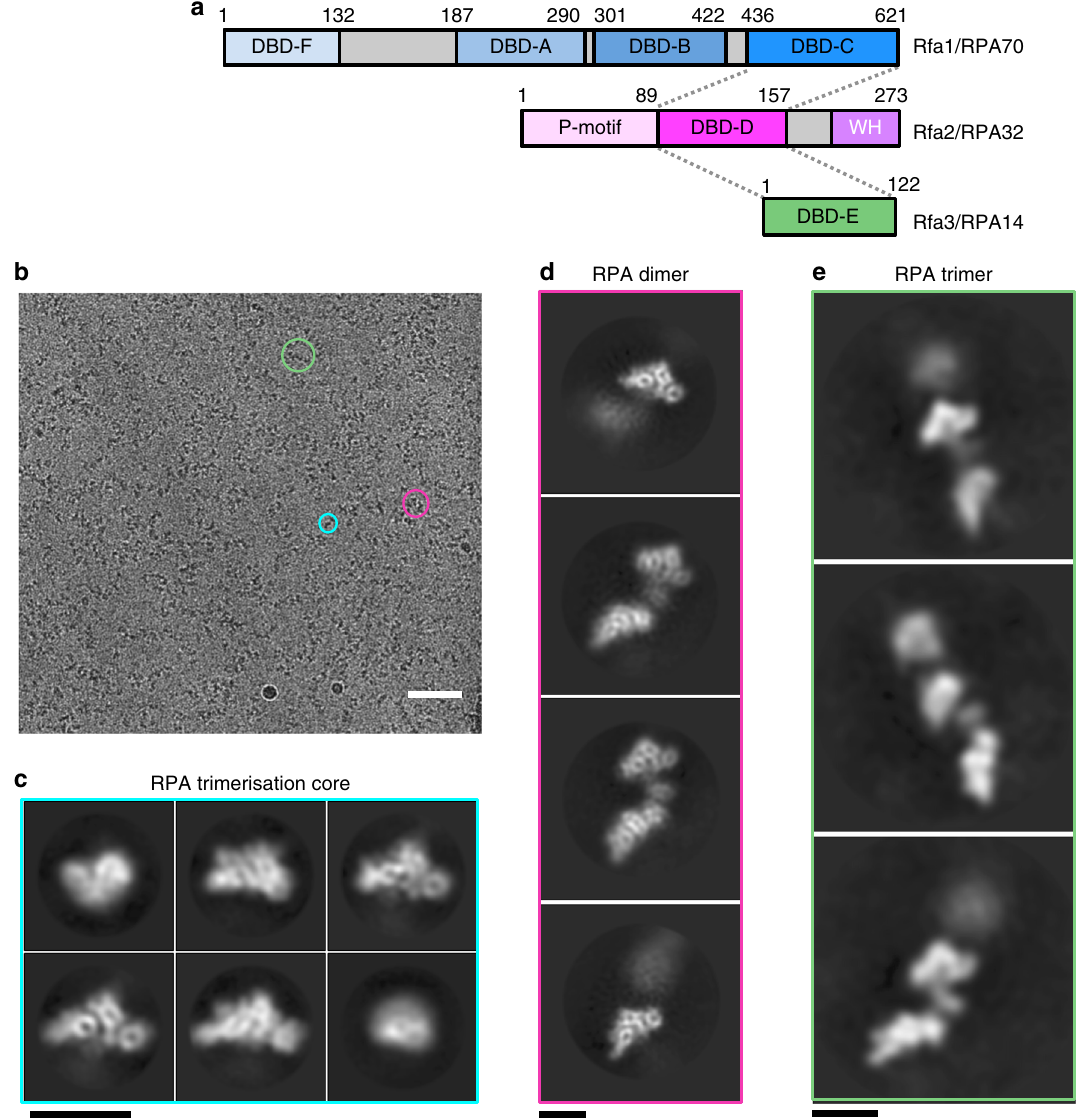
Fig. 1 Cryo-EM image analysis of RPA-coated ssDNA. a Schematic of the RPA subunits Rfa1, Rfa2, and Rfa3 that form the RPA complex. Domains are shown and labeled with those associated in the trimerisation core indicated by dotted lines. b A typical cryo-EM micrograph of ScRPA-dT 100 nucleoprotein complexes. Different types of single particles analyzed are circled. The 2D class averages that result from the types of particles are shown in b – d and are colored by Tri-C (blue), dimer (pink), and trimer (green). Scale bar represents 50 nm. c 2D-class averages of individual RPA trimerisation core heterotrimers. Scale bar in c – e represents ~80 Å. d 2D-class averages focusing on two RPA molecules. Two trimerisation cores (Tri-C) of RPA are clearly distinguishable in these images. However, there is some conformational fl exibility of the Tri-C relative to one another. In some classes it is also clear that there is a domain sandwiched between two RPA Tri-Cores. e 2D-class averages of ScRPA-dT 100 showing up to three molecules of RPA per oligonucleotide, which agrees with EMSA and SEC-MALS data (Supplementary Fig 2c,